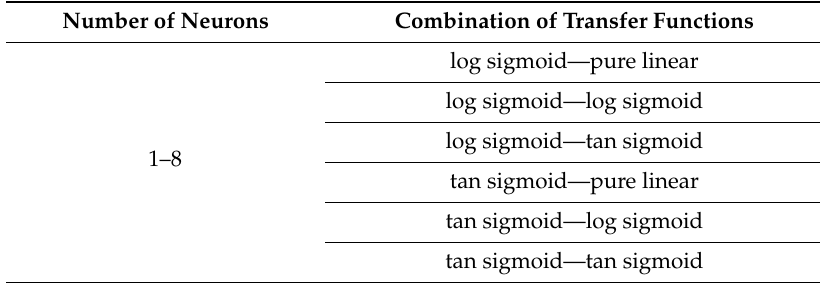
Table 3. Combinations of transfer